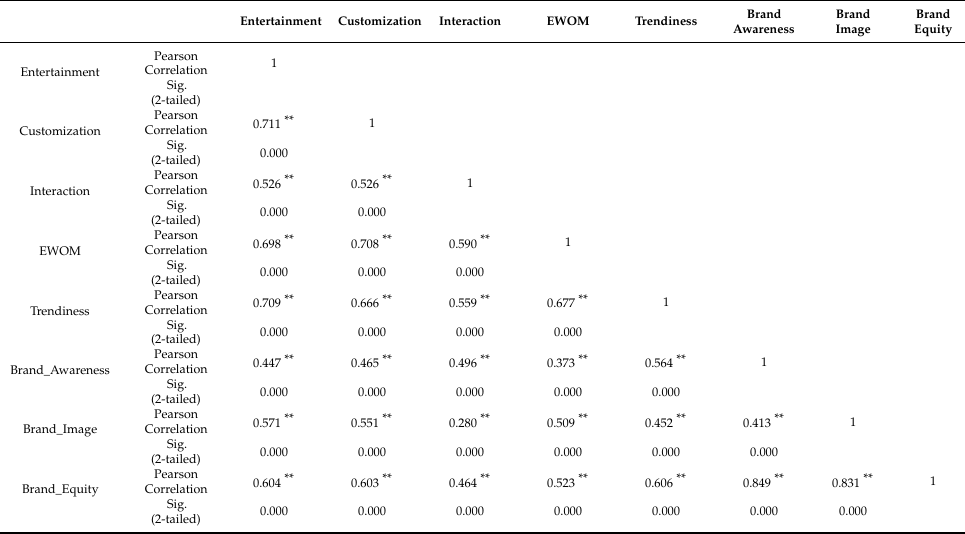
Table 3. Pearson Correlation (Independent and dependent variables).